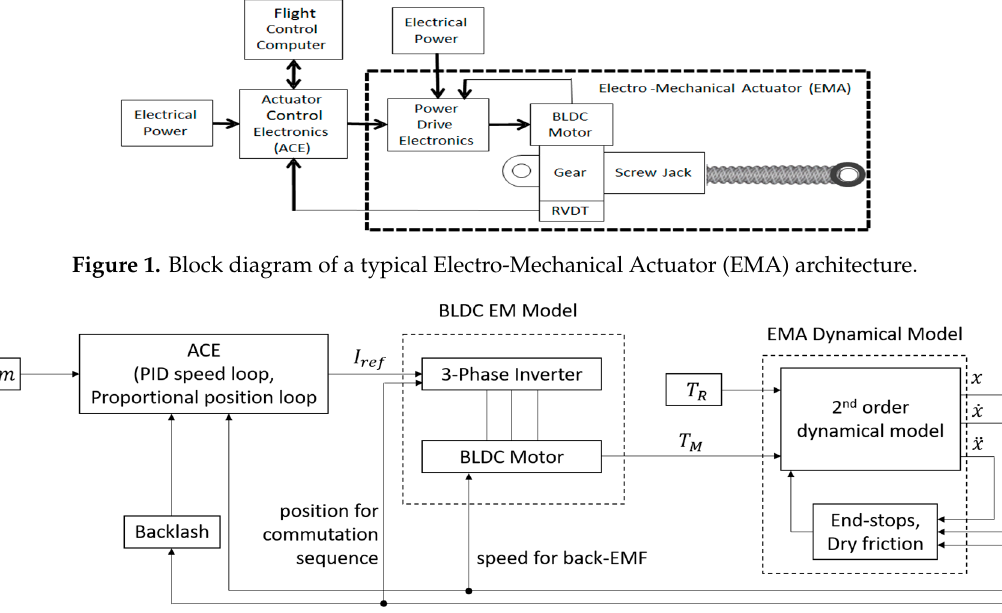
Figure 2. High-level block diagram the Reference EMA Model employed in this work. BLDC: BrushLess Direct Current; ACE: Actuator Control Electronics.